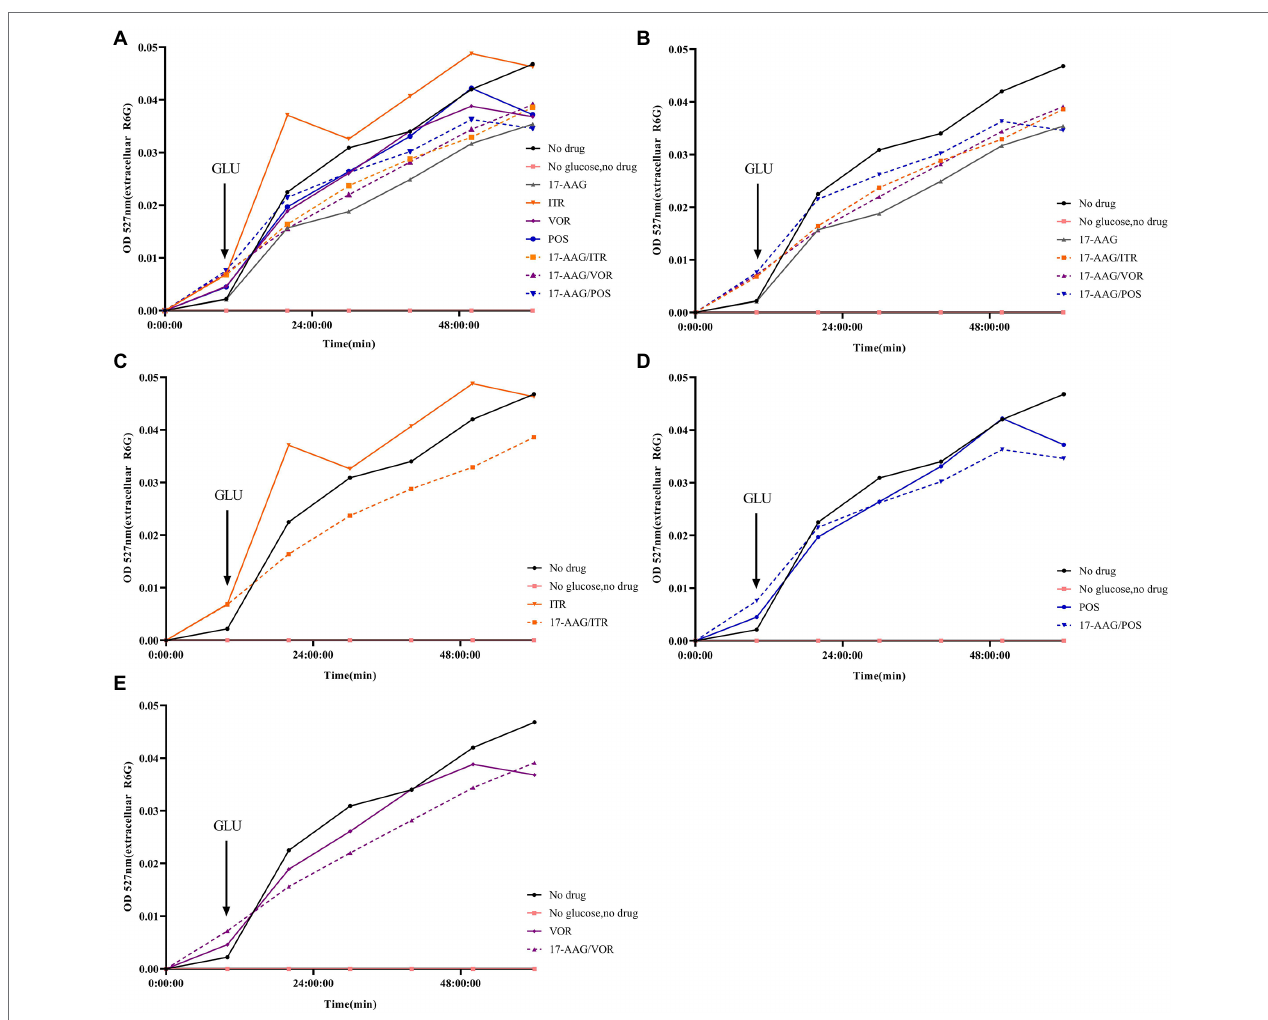
FIGURE 4 | Extracellular R6G measurements of 17-AAG and azole alone or in combination. (A) No drug+No glucose+17-AAG + ITR + VOR + POS + 17-AAG/ ITR + 17-AAG/VOR + 17-AAG/POS; (B) No drug+No glucose+17-AAG + 17-AAG/ITR + 17-AAG/VOR + 17-AAG/POS; (C) No drug+No glucose+ITR +